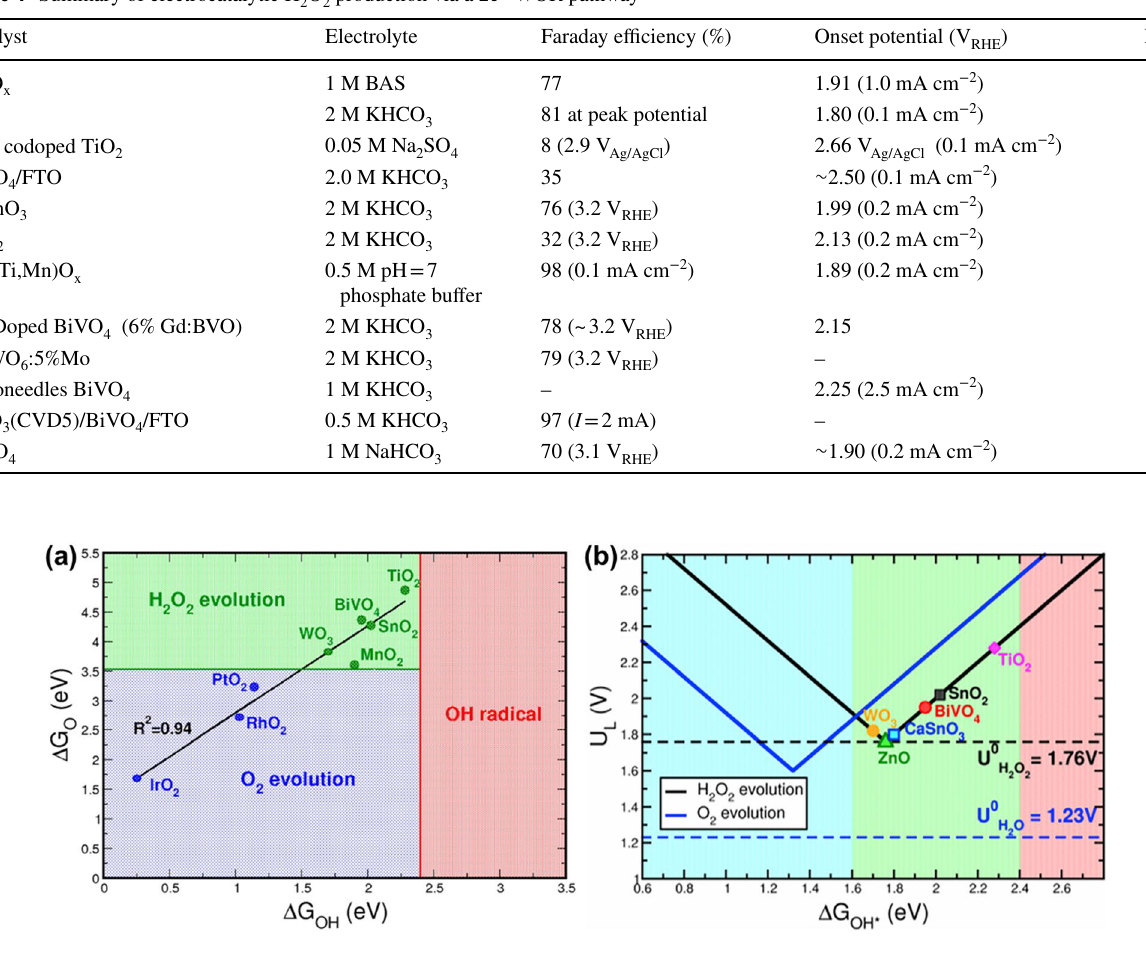
Fig. 18 a Phase diagram represented by the binding energies of O* and OH*. Reproduced with permission from Ref. [261]. Copyright 2017 American Chemical Society. b Activity volcano plots for the 2e − and 4e − WOR. Reproduced with permission from Ref. [54]. Copyright 2020